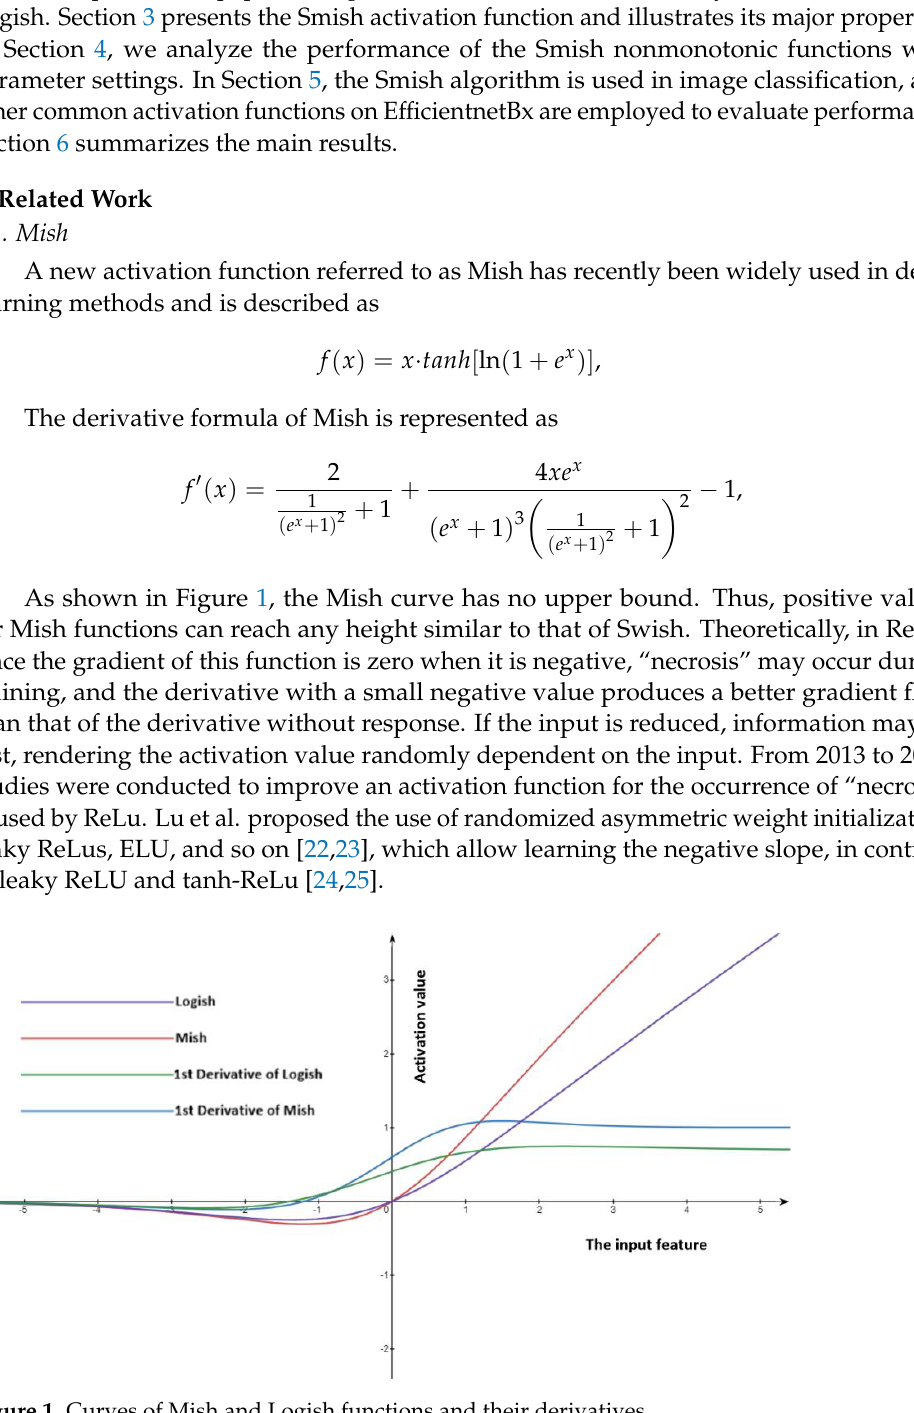
Figure 1. Curves of Mish and Logish functions and their derivatives.